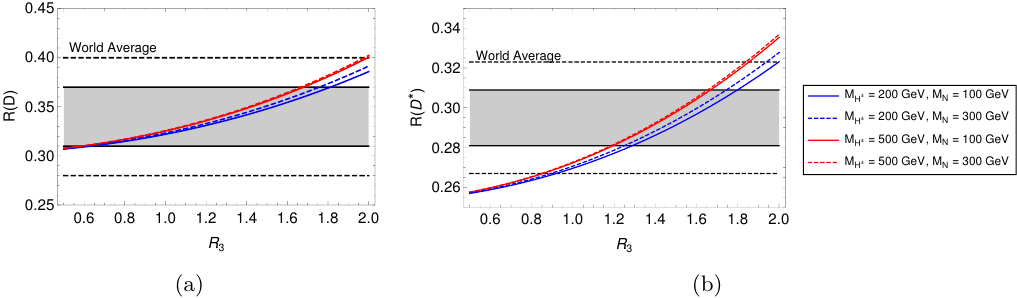
Figure 11 . Variation of R ( D ) and R ( D ∗ ) with coupling R 3 for two different values of M M N as shown by the legends. The grey bands are the respective 1 σ ranges of the world averages of these observables [7]. The dashed lines are the similar 2 σ ranges of the data. We have plotted these for M = M and R 1 = 0 . 2 H 0 H ±